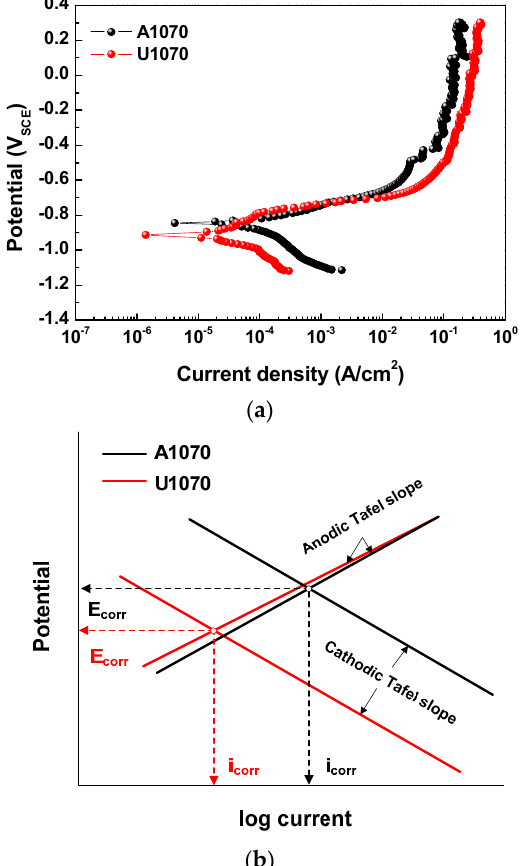
Figure 3. ( a ) Polarization curves and ( b ) schematic Tafel slope of A1070 and U 1070 in a salt water–acetic acid solution at 47 °C.